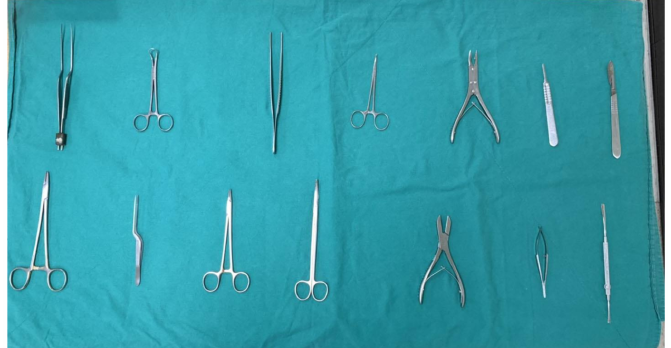
Figure 1. Examples of the instruments to be recognized in this study.